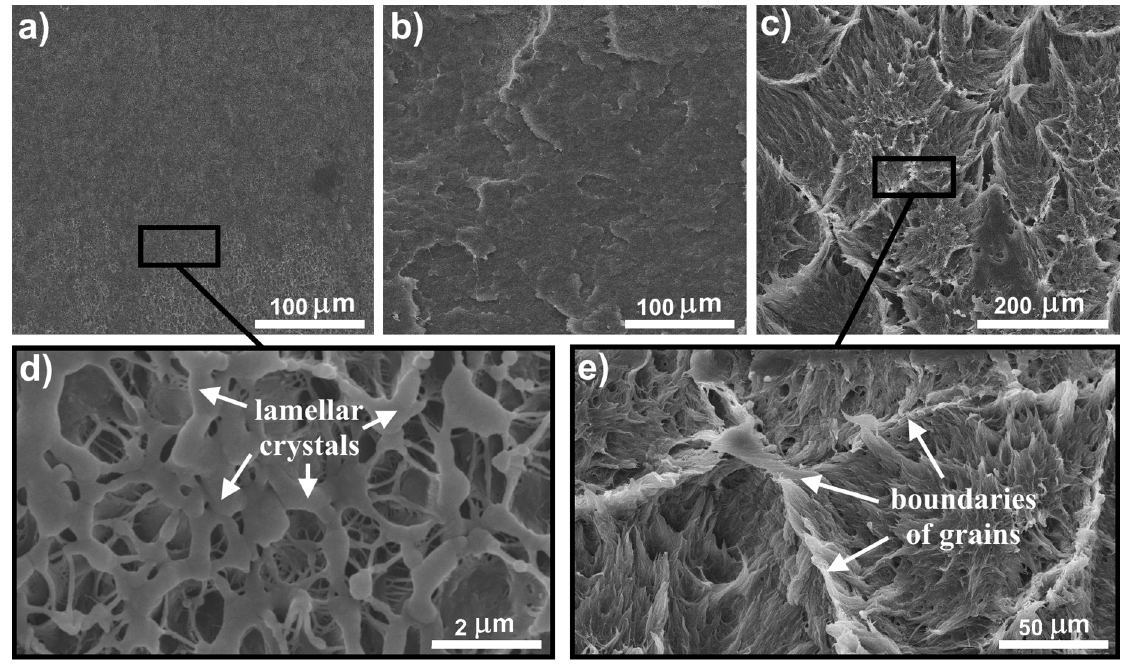
Figure 1. SEM of supramolecular structure of xerogel UHMWPE/FMWCNT with different contents of nanotubes ( a ) 0, 0.05, and 0.1 wt %, ( b ) 0.5 wt %, and ( c ) 1 wt %. The ( d ) scaled area shows the lamellar structure (content of FWMCNT 0, 0.05, and 0.1 wt %). The ( e ) scaled area shows the fibrillar structure and the boundaries grains of initial UHMWPE particles (content of FWMCNT 1 wt %). UHMWPE/FMWCNT, ultrahigh molecular weight polyethylene/fluorinated multi-walled carbon nanotubes.